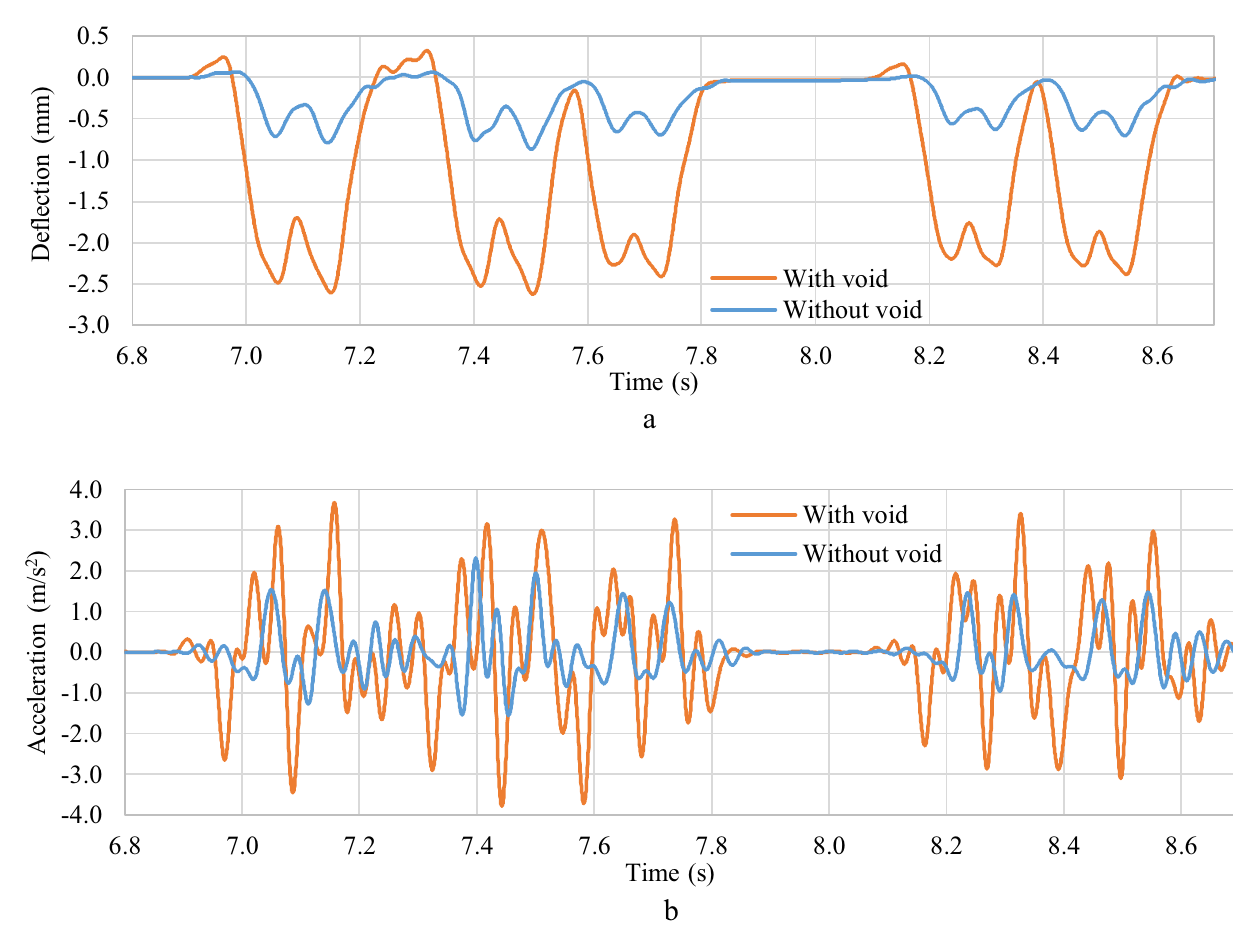
Fig. 6 Measured rail deflections ( a ) and accelerations derived from LVDT ( b ) in the voided zone (case 1) and the reference